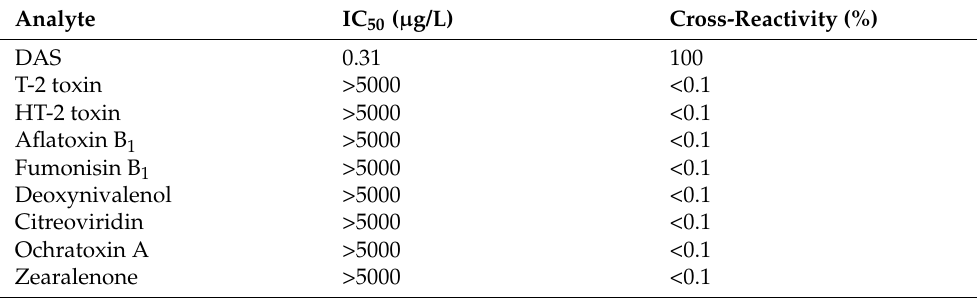
Table 2. The cross-reactivity (CR) values of the ELISA for detecting DAS and analogs.